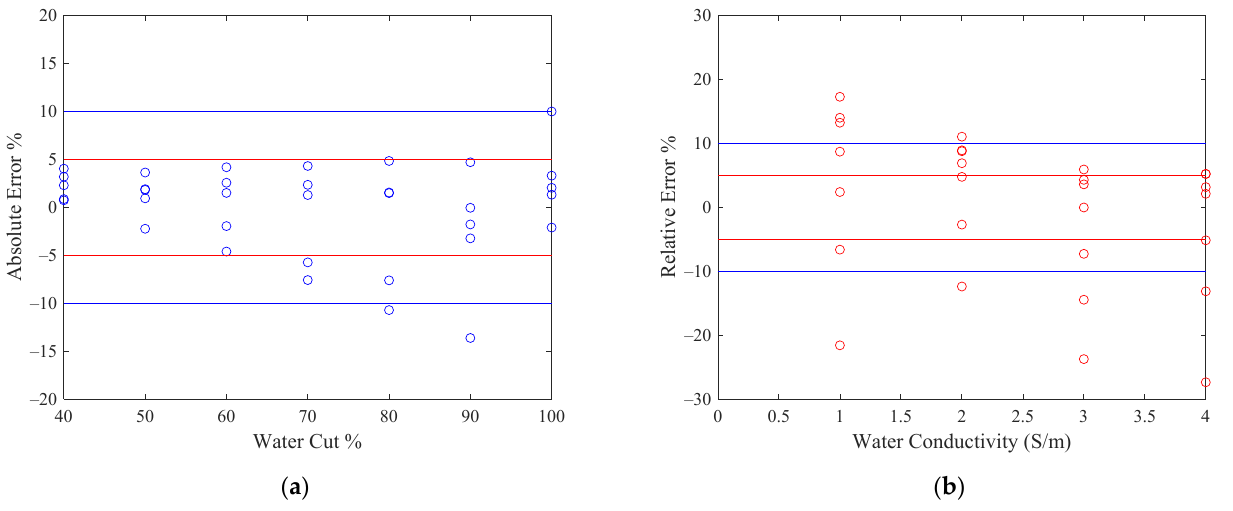
Figure 7. The measurement error of the iteration algorithm and microwave sensor for water- continuous flow conditions: ( a ) the absolute error of water cut; ( b ) the relative error of water conduc- tivity. The red lines denote the ± 5% error range and the blue lines denote the ± 10% error